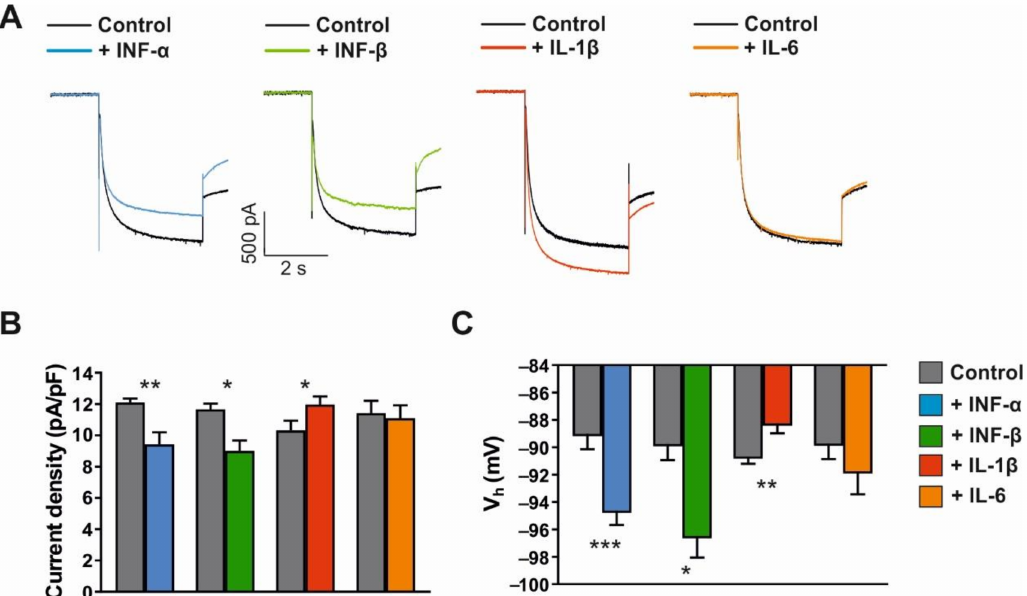
Figure 8. The impact of pro-inflammatory cytokines on I h properties in TC VB neurons. ( A ) Exem- plary traces of I h current recorded in TC VB neurons under control conditions and in the presence of IFN- α , IFN- β , IL-1 β and IL-6. ( B , C ) The bar graphs comparing the current density ( B ) and V 0.5 ( C ) before (Control) and after application of IFN- α , IFN- β , IL-1 β and IL-6. *, **, and *** indicate p values less than 0.05, 0.01, and 0.001,